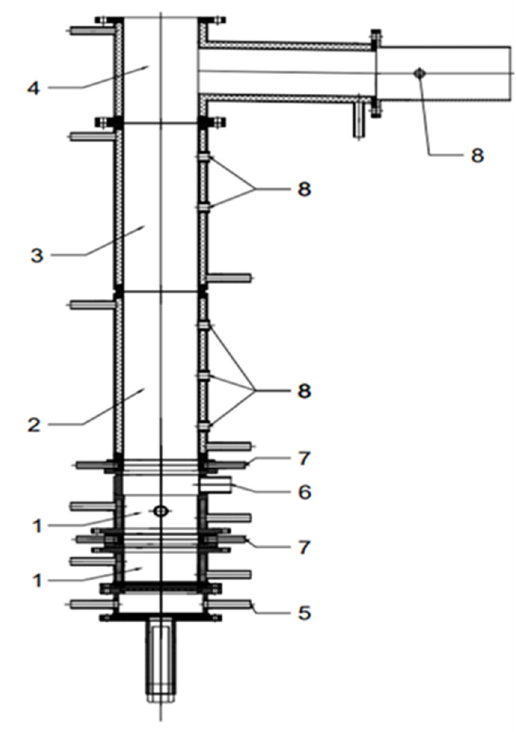
Figure 1. A sketch of the experimental device: 1––gasifier; 2, 3, 4––water-cooled sections of the combustor; 5––primary air supply nozzle; 6––propane flame supply nozzle; 7––secondary air sup- combustor; 5—primary air supply nozzle; 6—propane flame supply nozzle; 7—secondary air supply ply nozzle; 8––orifices for the diagnostic tools. nozzle; 8—orifices for the diagnostic